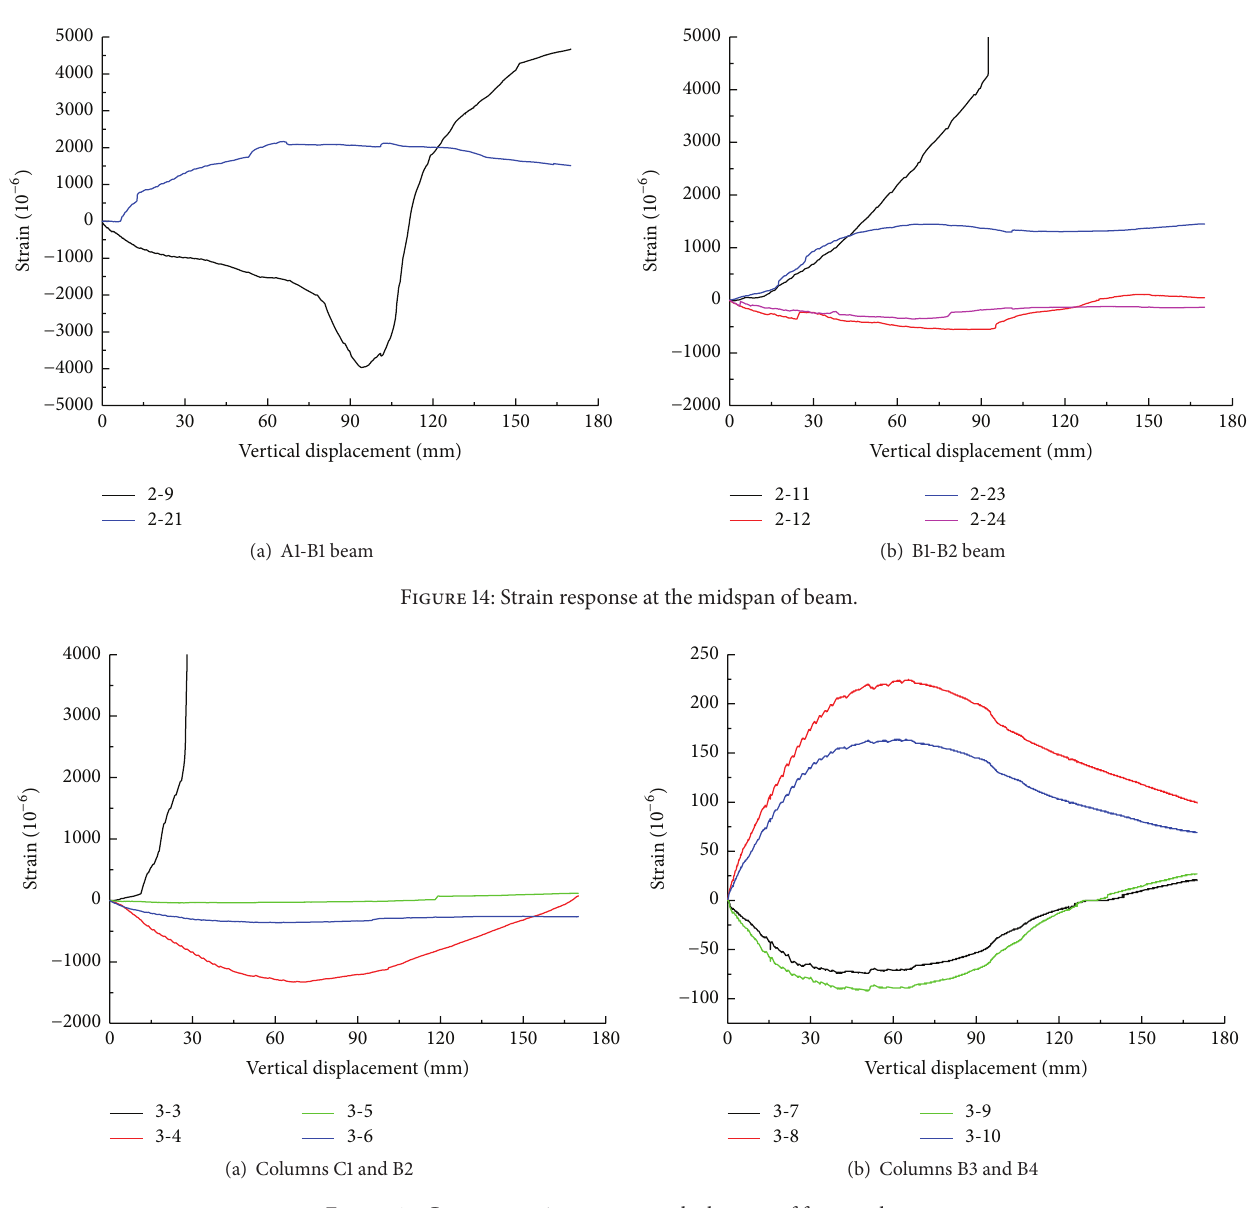
Figure 15: Concrete strain response at the bottom of frame